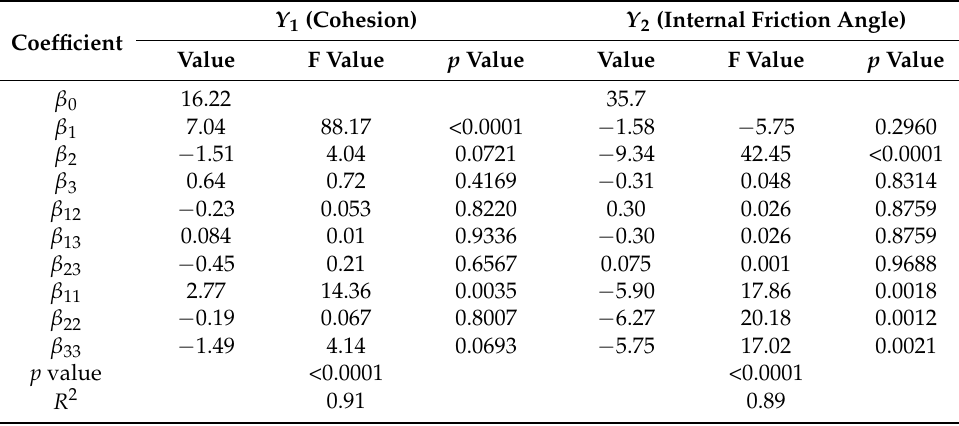
Table 4. Variance analysis of factors to cohesion and internal friction angle.